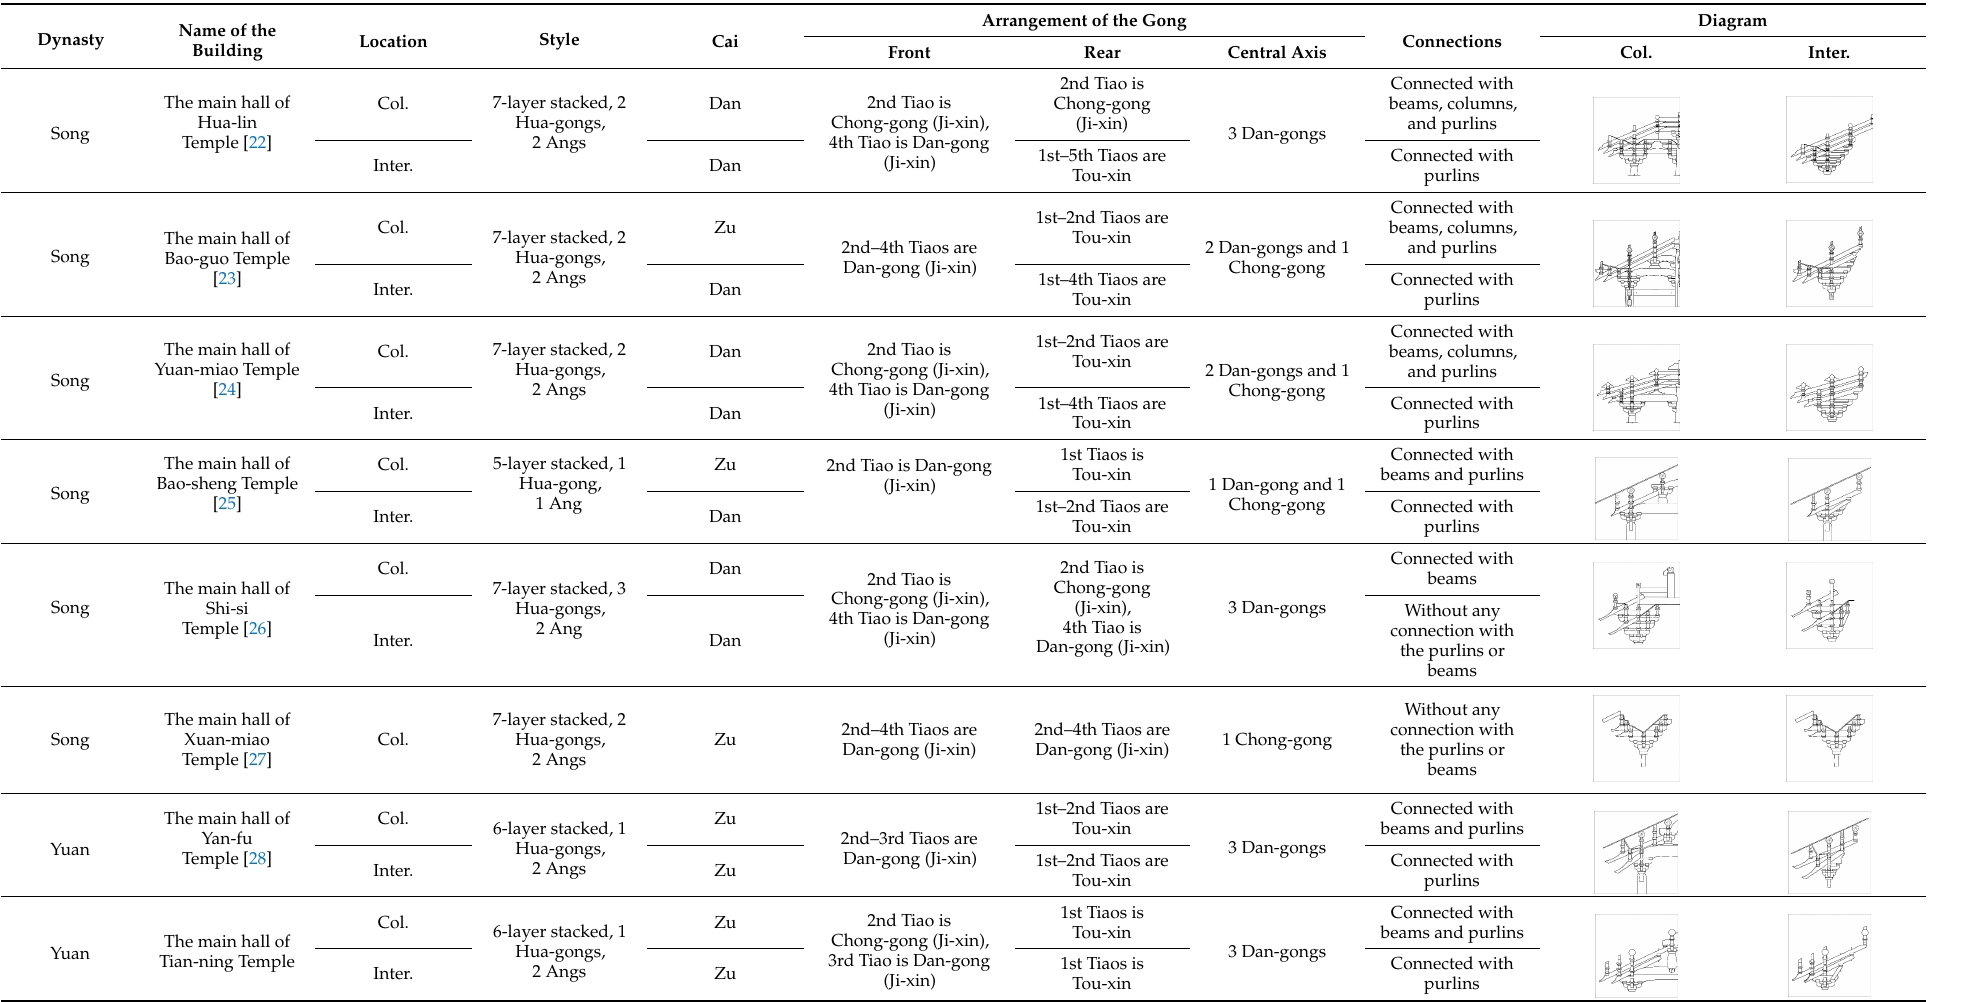
Table 1. Characteristics of Dou-gongs in the ancient Chinese timber buildings from the time of the Song and Yuan